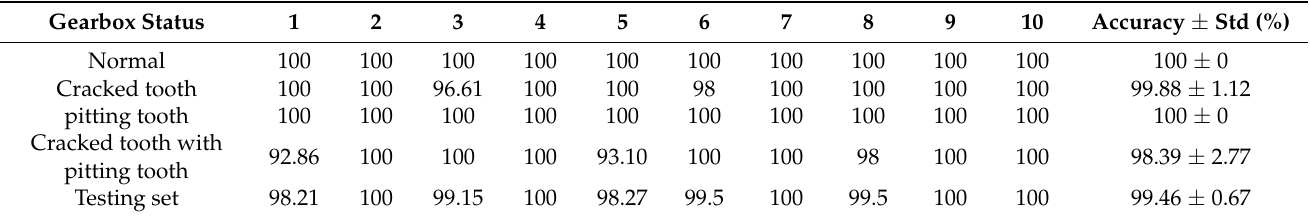
Table 7. Parallel experimental results of simulation data for CSAM-MSCNN.